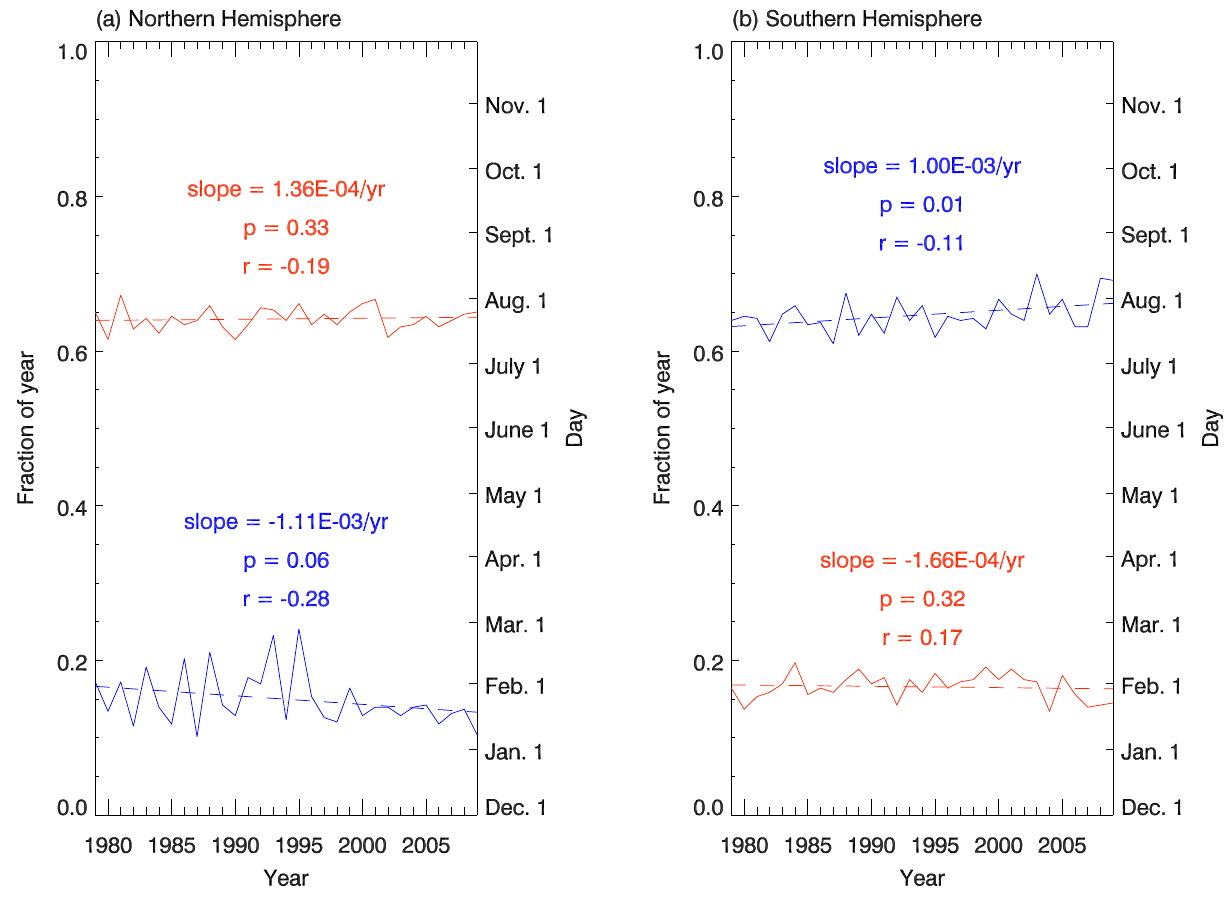
Figure 3. Same as Figure 1(a) but for the (a) Northern and (b) Southern Hemisphere separately. Only the Southern Hemisphere minimum date regression is significant at